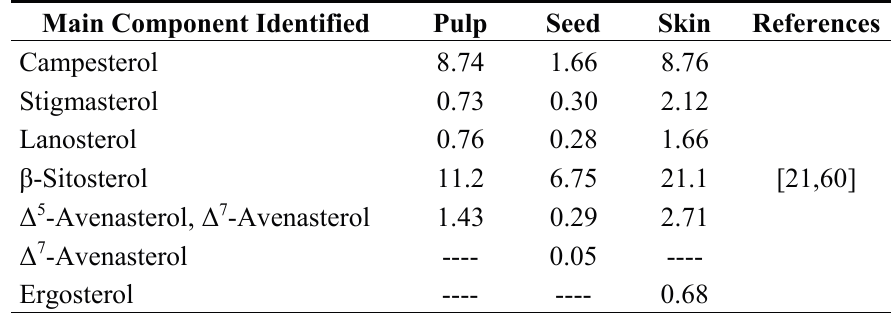
Table 4. Distribution and contents of sterols in the various parts of the O. ficus-indica fruit including pulp, seeds and skin. Sterol contents are expressed in